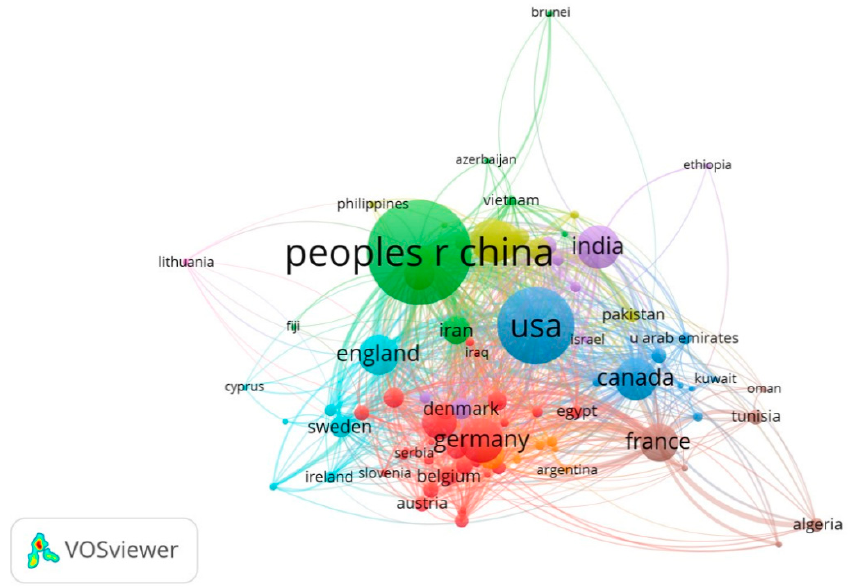
Figure 4. Network visualization of the most productive countries in VEs research